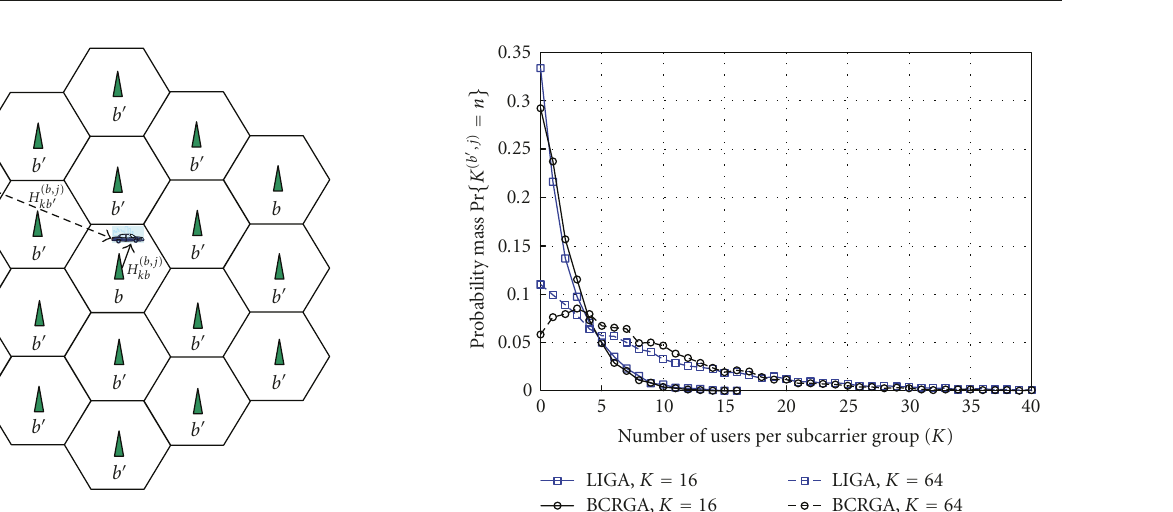
Figure 4: Simulation network. Figure 6: Probability distribution of number of users per assign- ment group in LIGA and BCRGA without code constraints on the number of users per assignment group (WFPA in